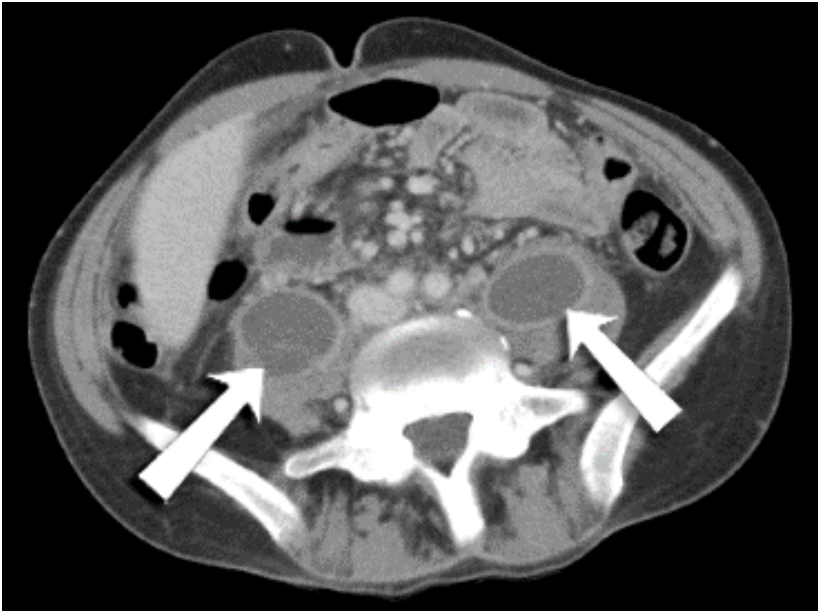
Figure 1. This is an axial view demonstrating bilateral psoas abscesses with